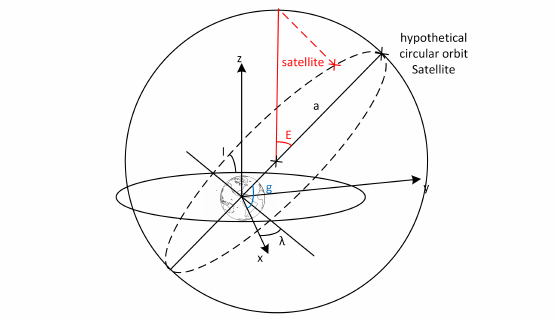
Figure 2. Illustration of the key satellite orbital parameter used in the SGP4 model where E is the eccentric anomaly of the satellite at time